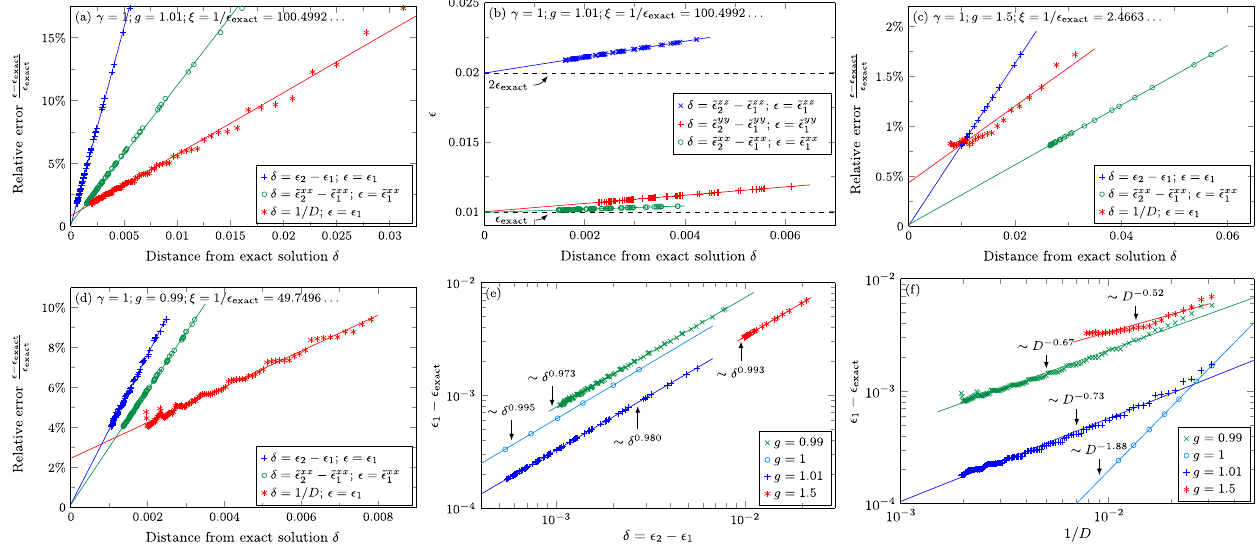
FIG. 2. Extrapolation of the correlation length in the Ising model, γ ¼ 1 . See text for discussion. (a) Paramagnetic phase with g ¼ 1 . 01 and results for bond dimensions D ¼ 32 – 512 with step dD ¼ 4 . Points represent numerical data and solid lines correspond to linear fits. (b) For g ¼ 1 . 01 each TM eigenvalue (or at least a few dominant ones) have nonzero form factor corresponding to exactly one of the R Þ , C R Þ , C R Þ . This allows us to distinguish that the correlation length associated with C correlators, C xx ð yy ð zz ð compared to the other ones. Here, D ¼ 128 – 512 . (c) Results for g ¼ 1 . 5 show that even far away from the critical point g extrapolation is necessary to precisely recover the correlation length. Here, D ¼ 32 – 128 . (d) Results for g ¼ 0 . 99 in the ferromagnetic phase. (e),(f) Log-log plots show error ϵ 1 − ϵ as a function of refinement parameter δ suggested in this article, as well as a function of D . exact This validates the general extrapolation model in Eq. (15) and further shows that the extrapolation method based on D is less